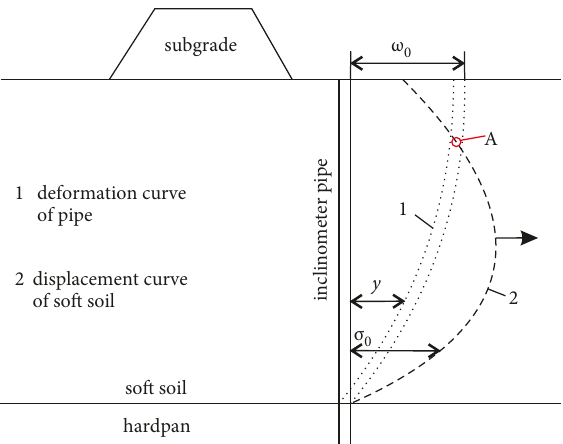
Figure 1: Schematic of the inclinometer pipe and soft soil deformations.